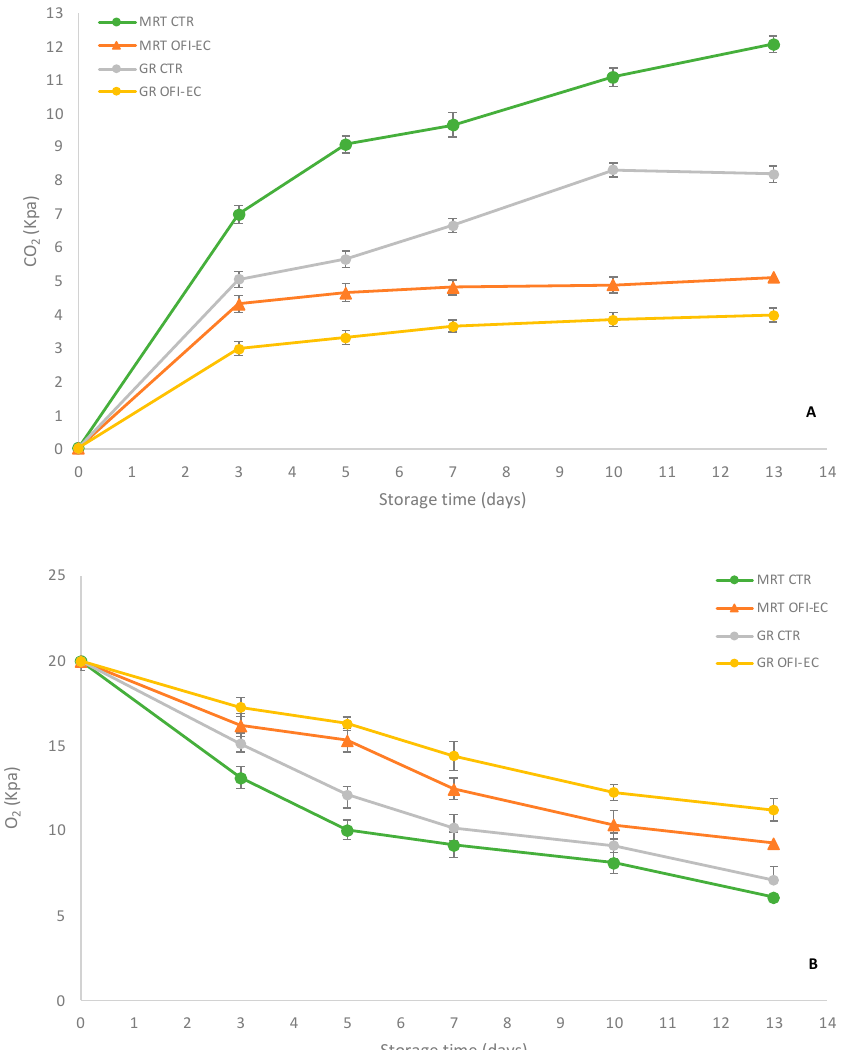
Figure 4. Concentrations of CO 2 ( A ) and O 2 ( B ) in minimally processed loquat (cv Martorana and Gigante Rossa ), untreated fruit (CTR), and fruits treated with mucilage (OFI-EC) during cold storage (13 days at 5 °C). Data are the mean ± SE (bars represent standard error of the means; n = 5). After 13 days of cold storage, the O 2 /CO 2 in-package concentration (kPa) in MRT CTR and MRT OFI-EC, and GR OFI-EC and GR CTR was about 6/12, 9/5, 7/8, and 11/4, respectively (Figure 4A,B). MRT CTR and GR CTR fruits showed a higher respiration rate during cold storage than that of MRT OFI-EC and GR OFI-EC fruits; indeed, MRT CTR samples showed a loss in terms of in-package O 2 concentration of 74% from the beginning to the end of the cold storage; otherwise, the in-package O 2 concentration loss in MRT OFI-EC was 54% from the beginning to the end of the cold storage period (Figure 4B). Similar behavior in GR CTR samples showed a loss in terms of in-package O 2 concentration of 64% from the beginning to the end of the cold storage period, while the in-package O 2 concentration loss in GR OFI-EC was 44% from the beginning to the end of the cold storage period (Figure